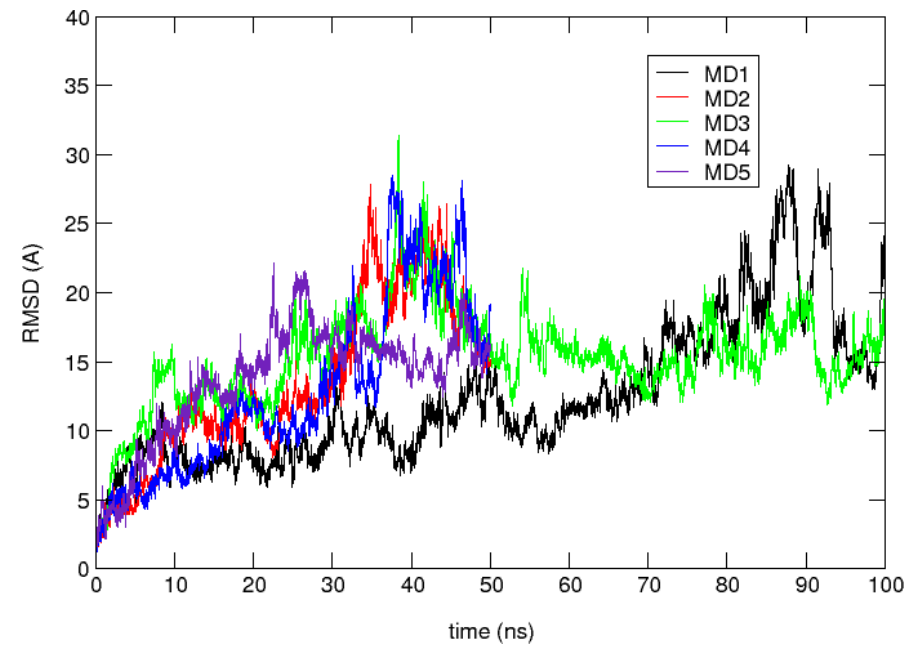
Figure 2. Root mean square deviation (RMSD) with respect to the initial structure as a function of time for 5 independent MDUF trajectories for U1A. Only MD3 and MD5 were extended; all were showing essentially similar behavior after 50 ns.